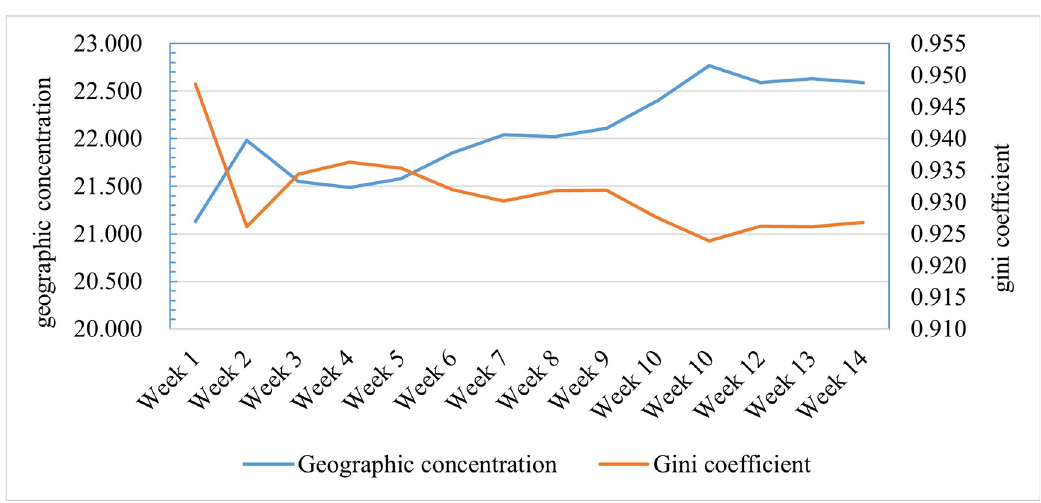
Fig 4. Novel coronavirus network geographic concentration index and Gini